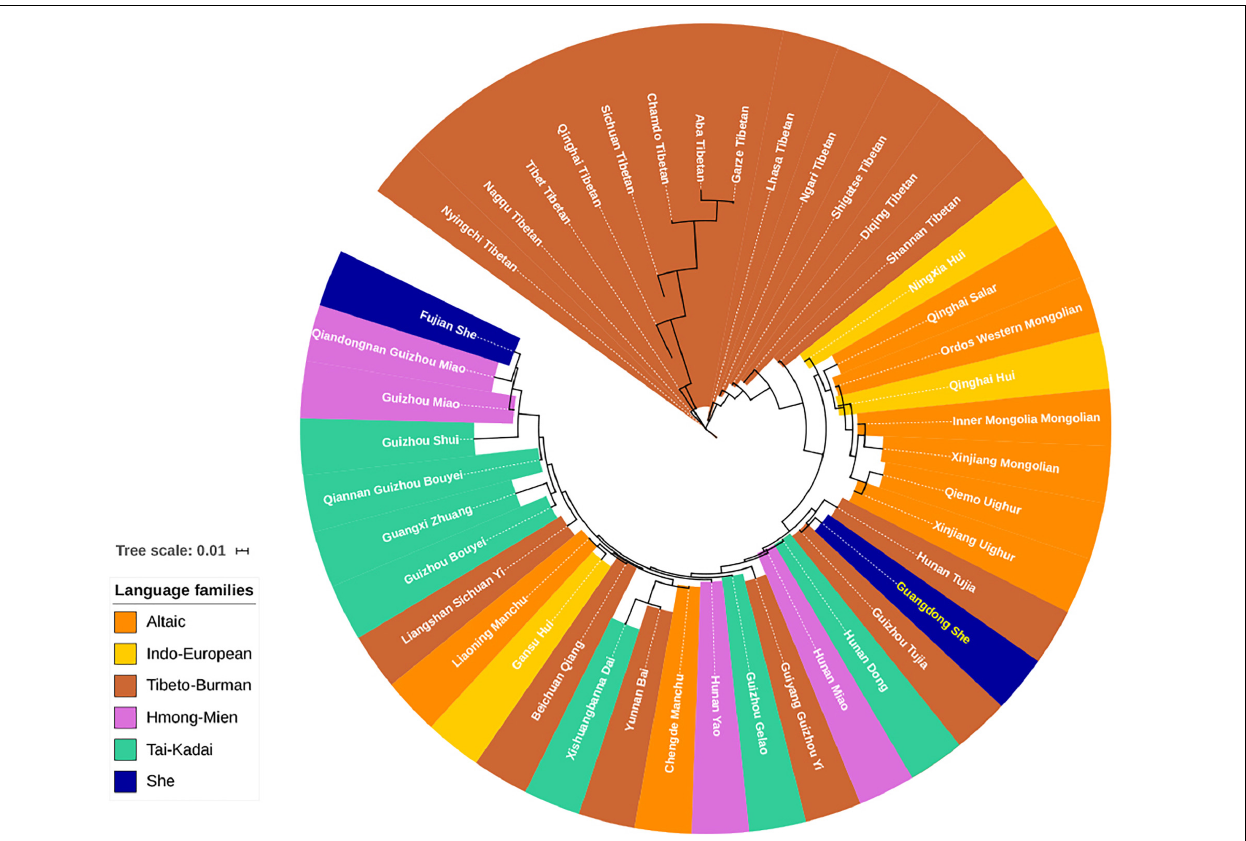
FIGURE 6 | Neighbor-joining phylogenetic tree between Guangdong She and 42 other minorities with five different language families based on pairwise R ST